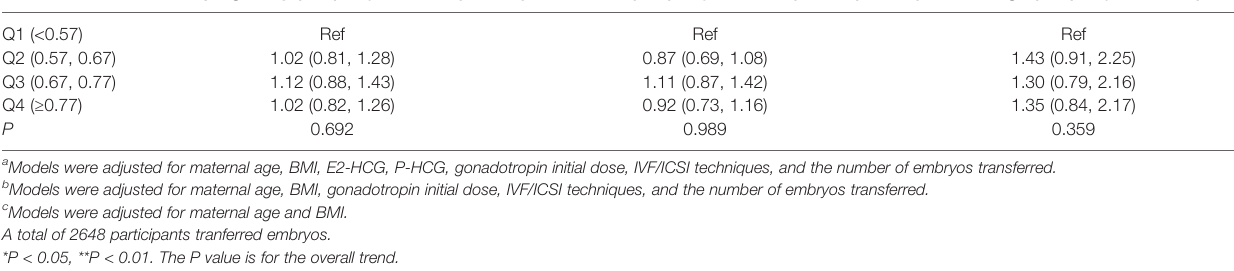
TABLE 5 | Clinical pregnancy, live birth and early miscarriage (95% CI) by quartile of OS/FP (N = 2683). Clinical pregnancy (rate) a Adjusted OR (95% CI) Live birth (rate) b Adjusted OR (95% CI) Early miscarriage (rate) c Adjusted OR (95% CI) Q1